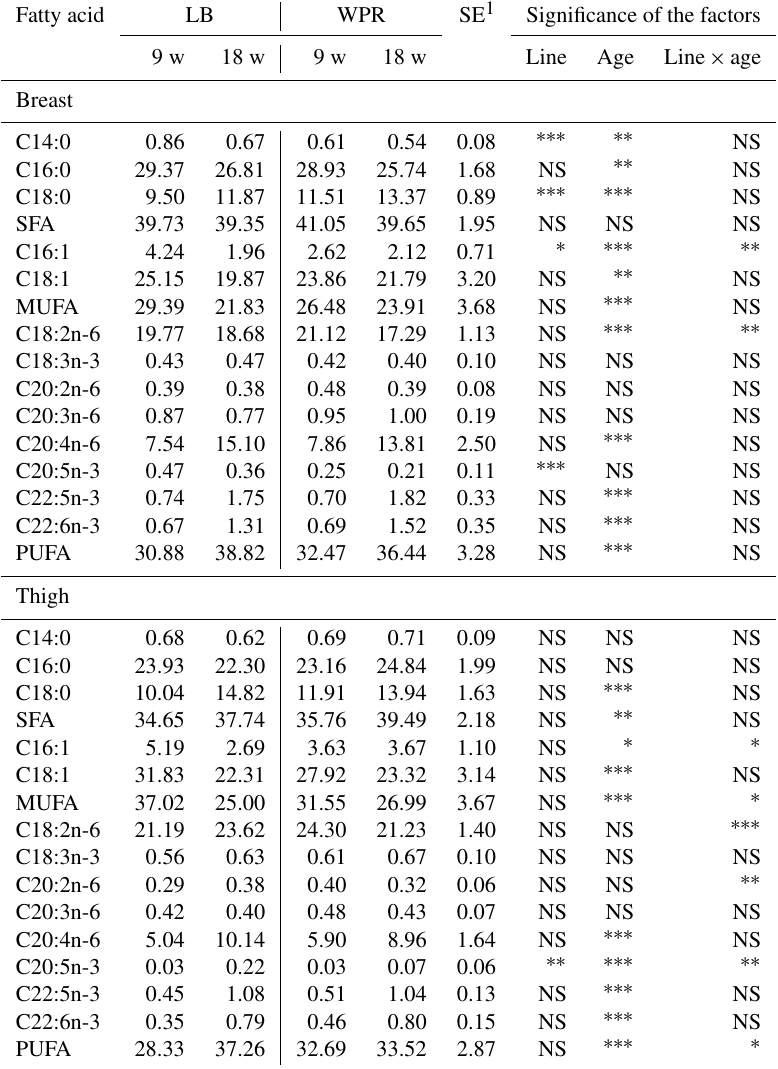
Table 3. Fatty acid composition (% of total FAME) of the breast and thigh in La Belle (LB) and While Plymouth Rock (WPR) chickens according to the line and